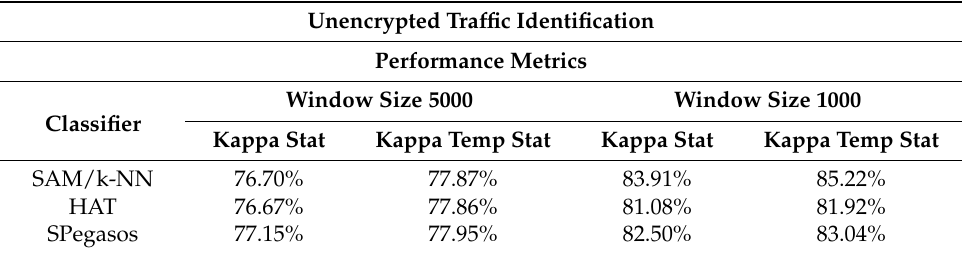
Table 11. Comparison between algorithms.